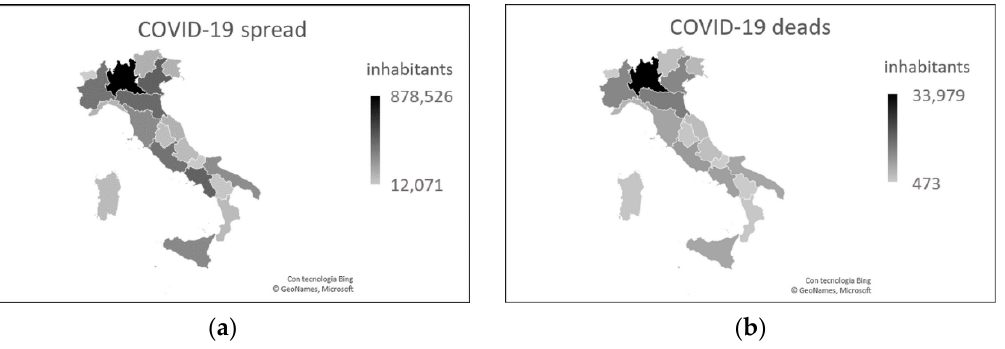
Figure 7. COVID-19 data as of September 17, 2021. ( a ) Number of cases. ( b ) Number of deaths. Both graphs show that Lombardy and northern Italy continue to be the areas most affected by this disease.